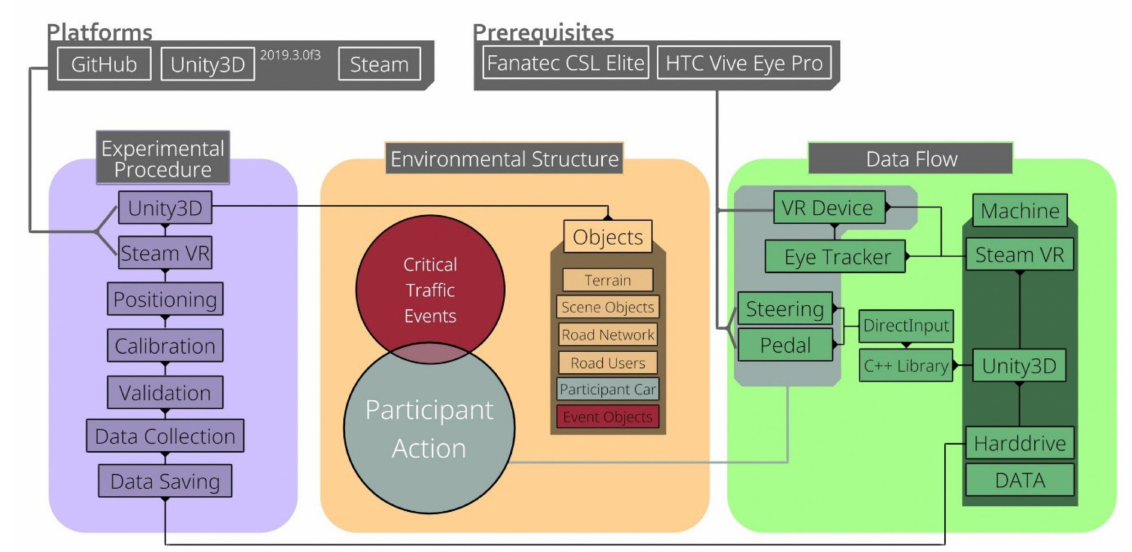
Figure 1. The current requirements only apply to the VR devices used and are not bound to the toolkit. The following figure depicts an overview of the default experimental procedure, environmental structure, and data flow of the toolkit. Again, all of these defaults can be adjusted at will. The configurations presented here are intended to allow for a quick adaptation to other experiments.